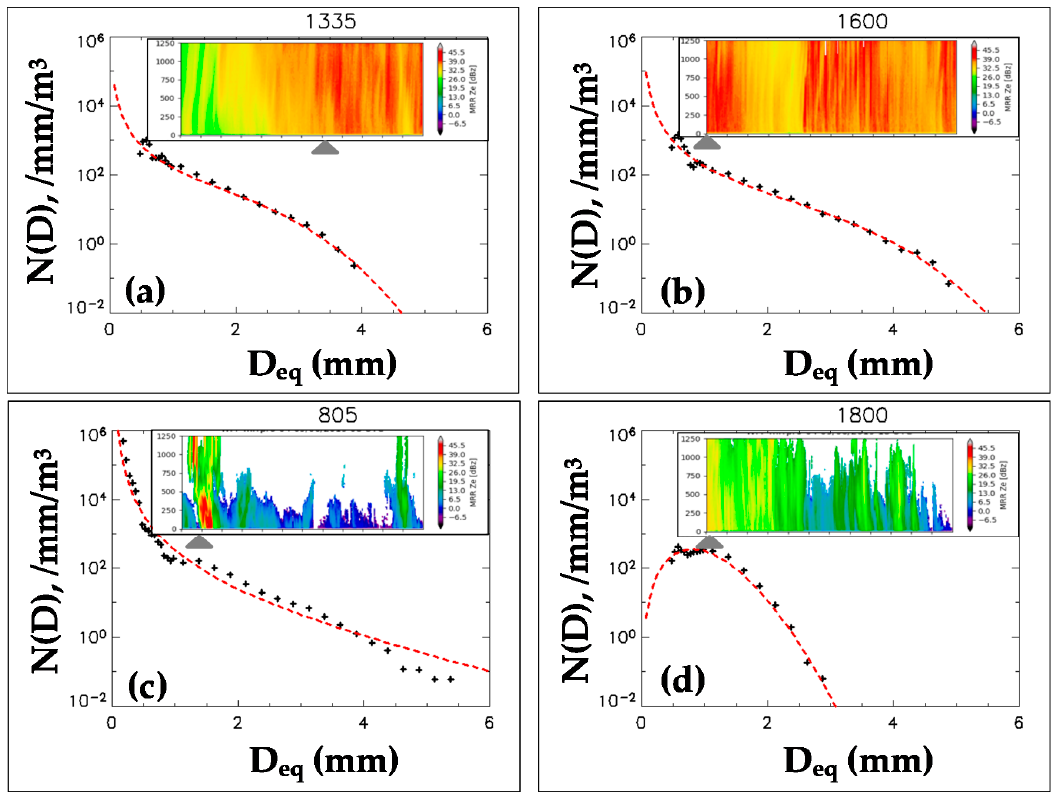
Figure 5. Four examples of 5 min DSDs (plus points) and their fitted generalized gamma (GG) curves (red dashed lines) for ( a ) 13:35–13:40, ( b ) 16:00–16:05, ( c ) 08:05–08:10, and ( d ) 18:00–18:05 UTC. Collocated micro-rain-radar (MRR) observations are included as an inset in each panel. Grey arrows represent the corresponding start times of the DSDs.